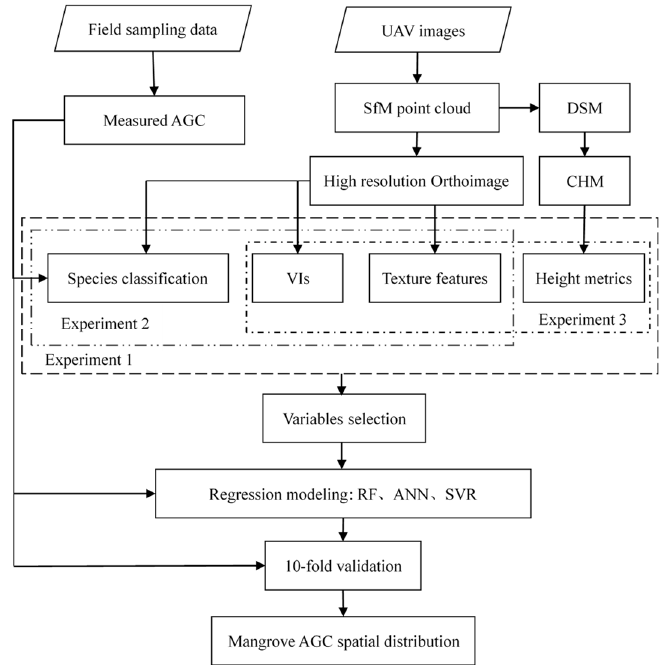
Figure 2. Flowchart of this study.